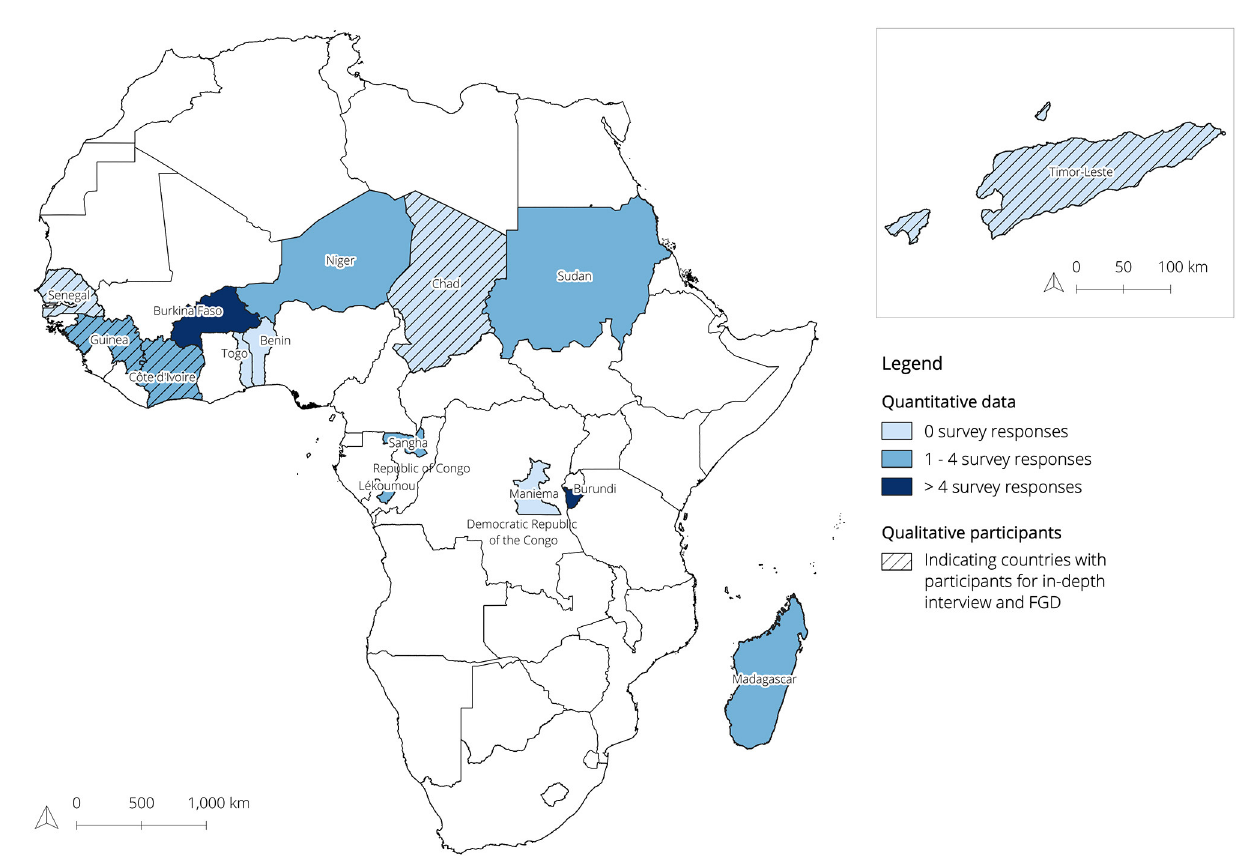
FIGURE2 Map showing where the UNFPA EmONC program was implemented by 2021, while indicating where survey (quantitative) and in-depth interview and FGD (qualitative) participants attended the TSWs. The blue color gradient indicates the number of survey responses. Dashed countries indicate countries where the in-depth interview and FGD participants attended TSWs. The combined exploratory- and in-depth interview participants together covered for TSW attendance in all 14 indicated